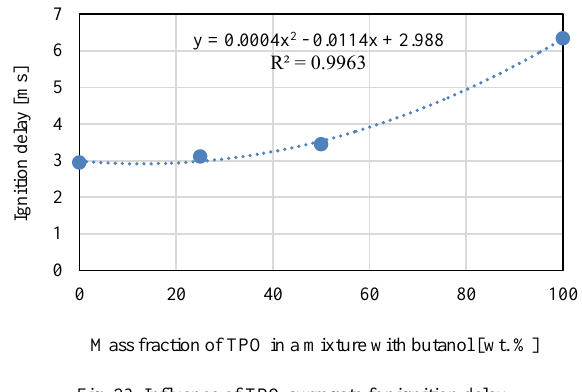
Fig. 23. Influence of TPO surrogate for ignition delay